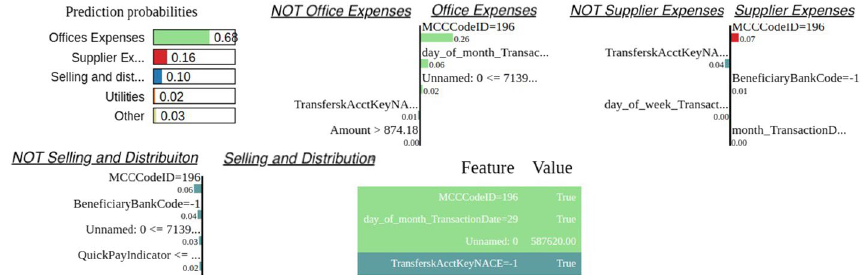
Fig. 9 An example of transaction categorization of LIME analysis, explaining the features and their values contribution these specific the outcomes of the model with the provided